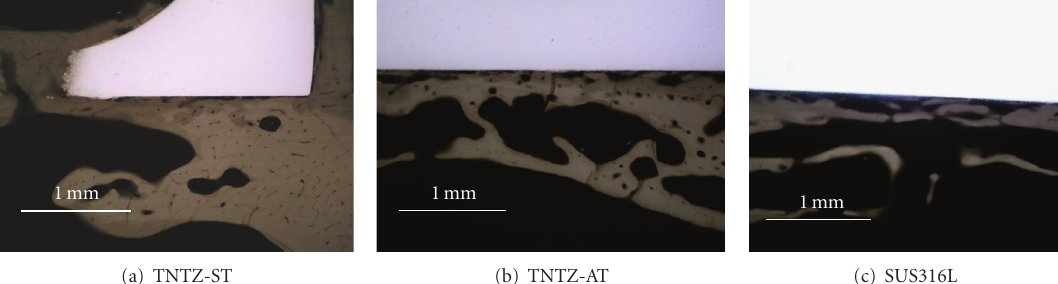
Figure 20: Optical photographs of bones formed around extracted bone plates made of (a) TNTZ-ST, (b) TNTZ-AT, and (c) SUS316L stainless steel fixed to tibiae of rabbits at 52 weeks after